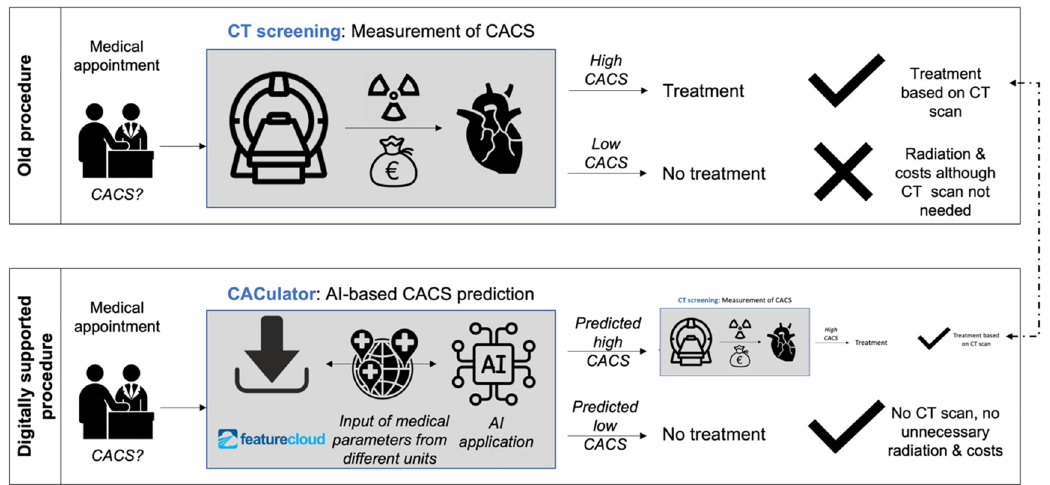
Figure 5: Comparison of the ‘‘analogue’’ and ‘‘digitally’’ supported CACS patient assessment and according benefits (Authors).